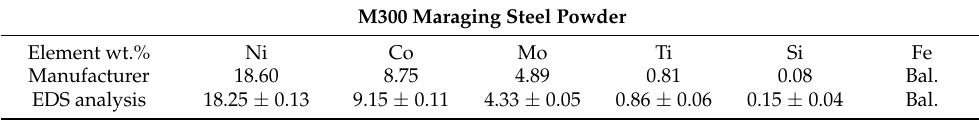
Table 2. Chemical composition of the M300 maraging steel.